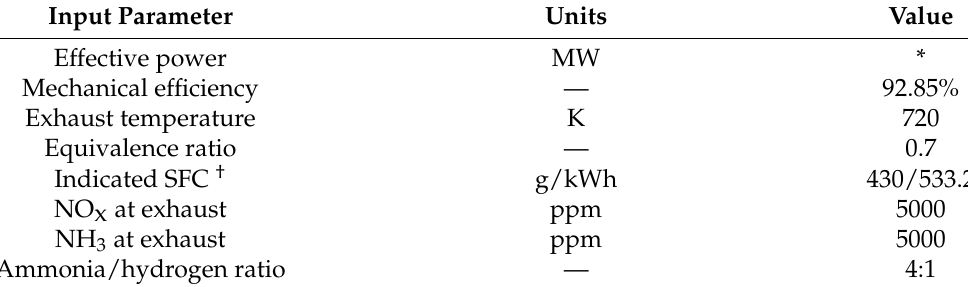
Table 3. The input parameters for the internal combustion (ICE) model based on data from Lhuil- lier et al. [10]. The primary input variable is the desired effective power, but all parameters can be changed to reflect new experimental data. * The effective power should match the power require- ments from Section 2.3. † Indicated specific fuel consumption (SFC) values are the published values prior to mass correction due to nitrogen dilution. The code corrects these values